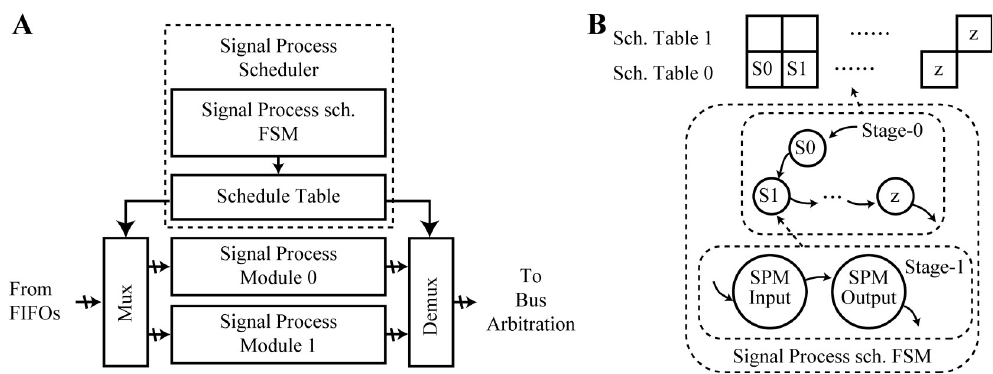
Fig 4. SPA flowchart and architecture. (a) Architecture and (b) signal process schedule FSM flowchart.